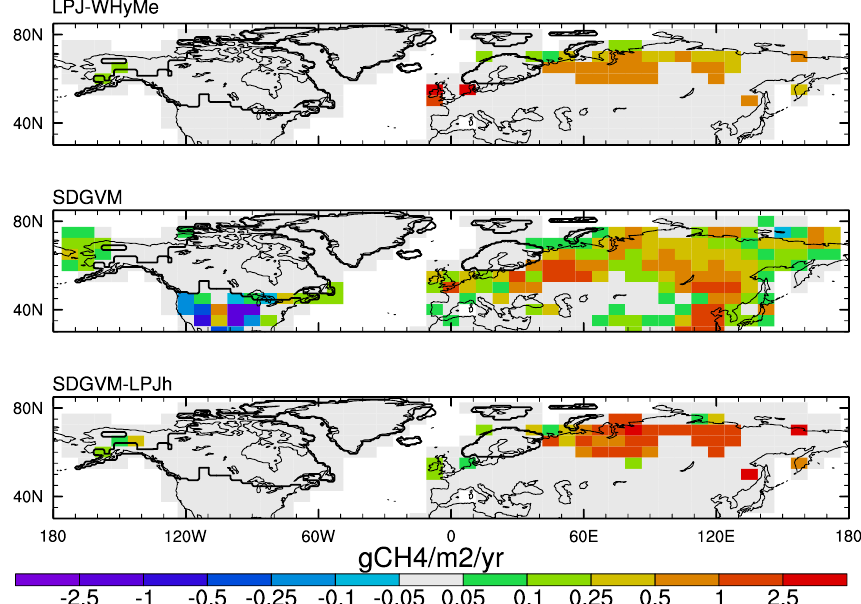
Fig. 9. CH 4 emission anomalies for GI–HS for 14kyr conditions in LPJ-WHyMe, SDGVM and SDGVM-LPJ-h, including a correction for the fractional land area in coastal grid cells. The distribution of land ice in each simulation is shown by the black contour line.